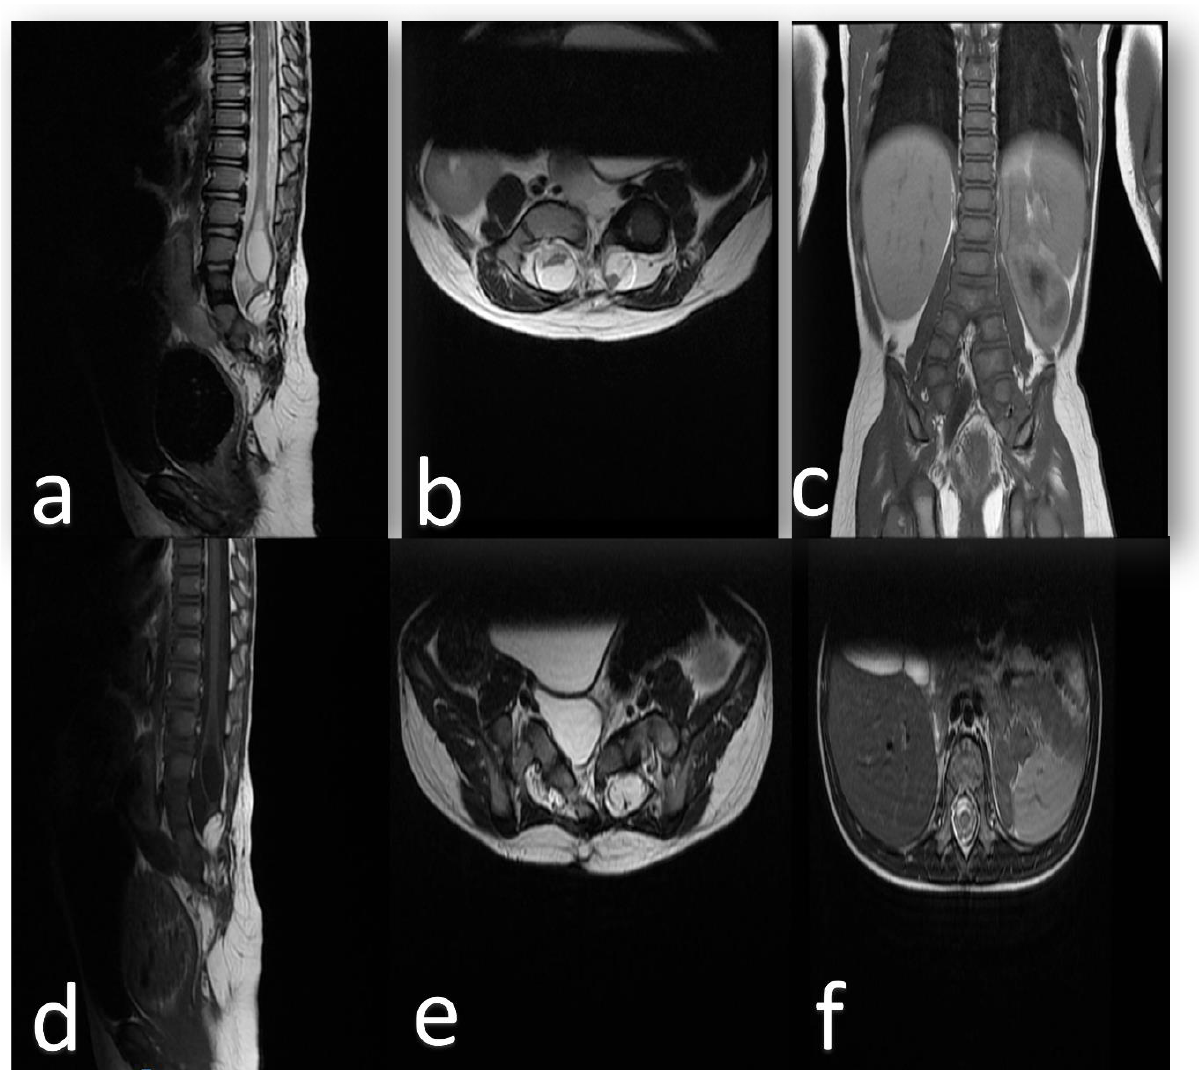
Figure 1. MRI ( a ) T2 sequence in the sagittal view shows hyperintense intramedullary syrinx associated with cord splitting at multiple lumbar segments. ( b ) Axial view shows the duplicated dural sacs. ( c ) Coronal view illustrates the associated spinal column division at the level of the aortic bifurcation. ( d ) T1 sequence in the sagittal view shows the same findings in ( a ); however, the lipoma is demonstrated caudally. ( e ) T2 sequence in the axial view the 2 duplicated cords inferior to the bifurcation level. ( f ) T2 sequence in the axial view the one spinal cord superior to the bifurcation level.